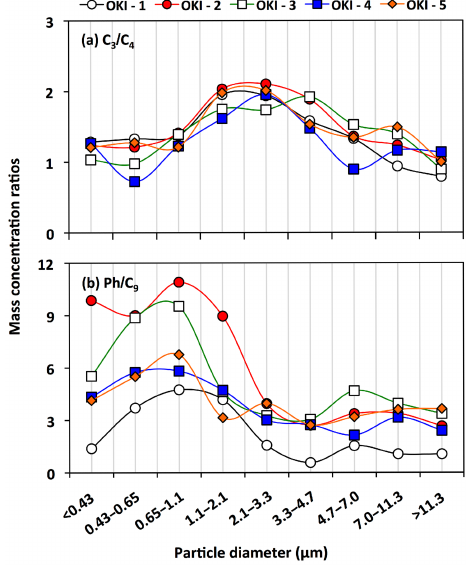
Figure 8. Mass concentration ratios of malonic to succinic acid and phthalic to azelaic acid in size-segregated aerosols collected on Ok- inawa